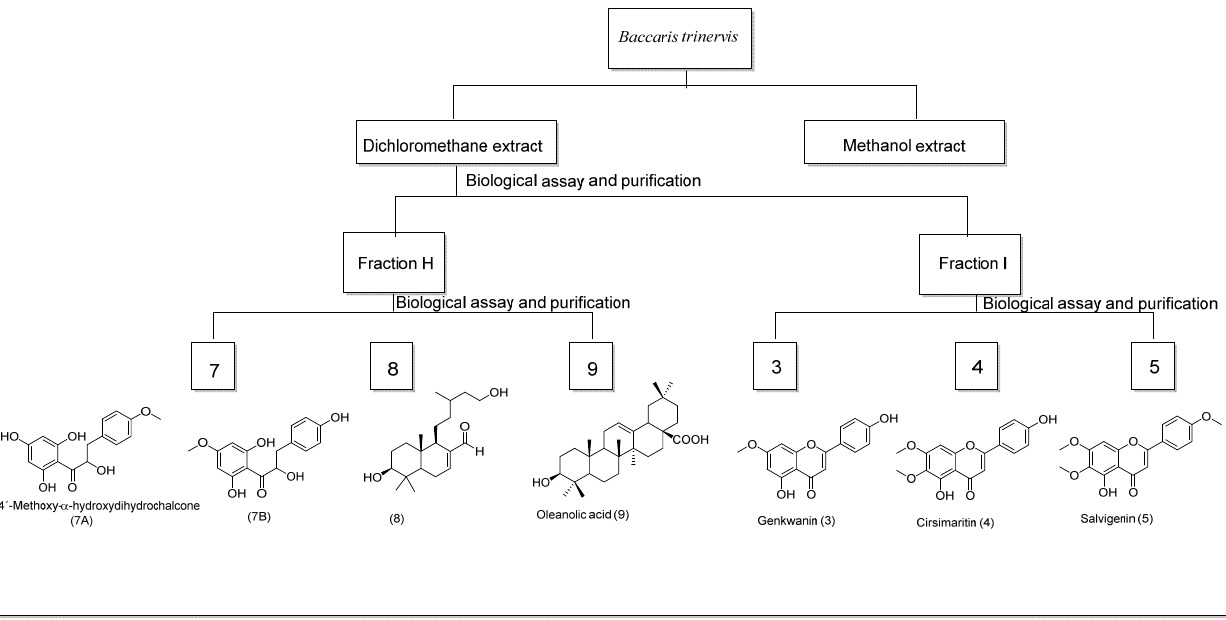
Figure 2. Scheme of the bio-guides isolated compounds from Baccharis trinervis .